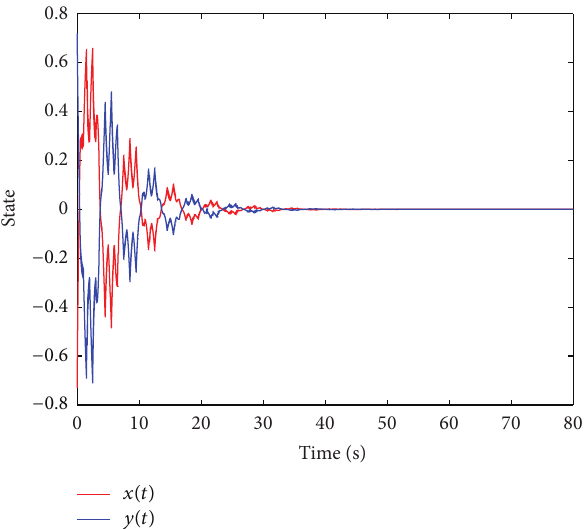
Figure 7: Simulation of the system (75) under the semi impulsive control.